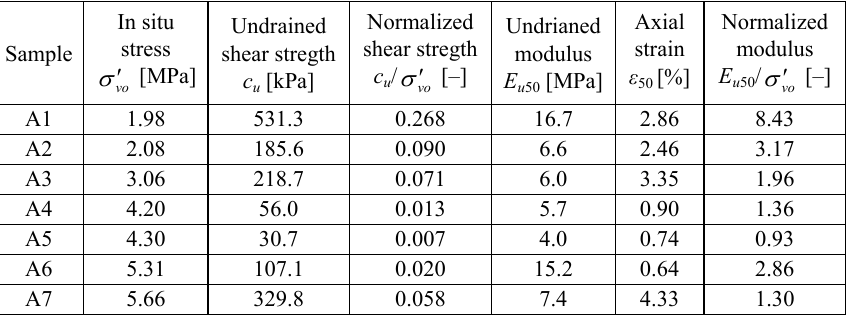
Table 2. Results of unconfined compression